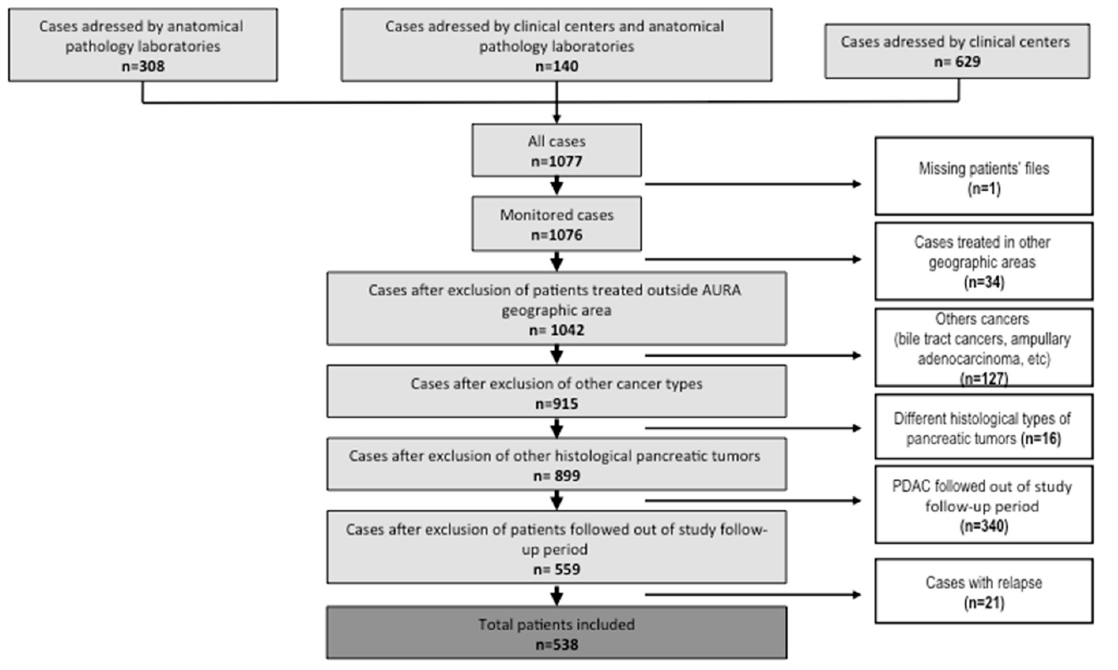
Figure 1. Flowchart.